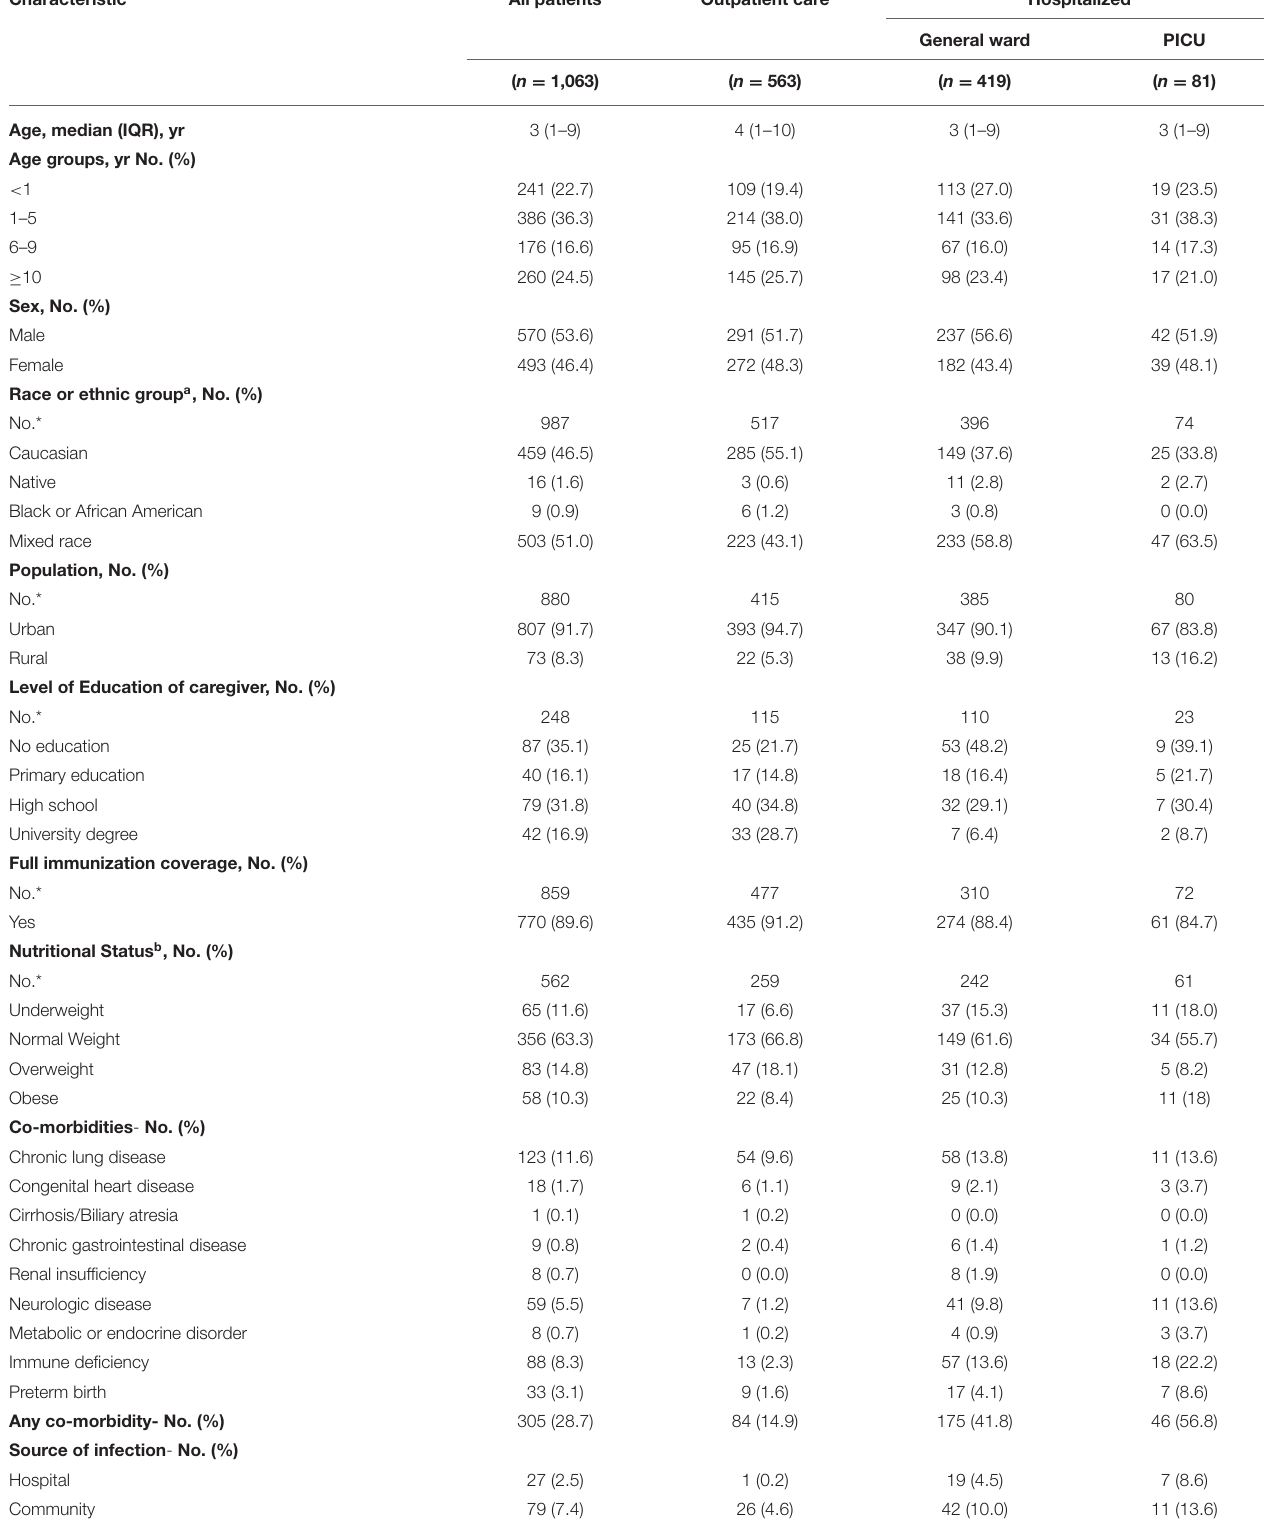
TABLE 1 | Demographics and clinical characteristics of pediatric patients with COVID-19. Characteristic All patients Outpatient